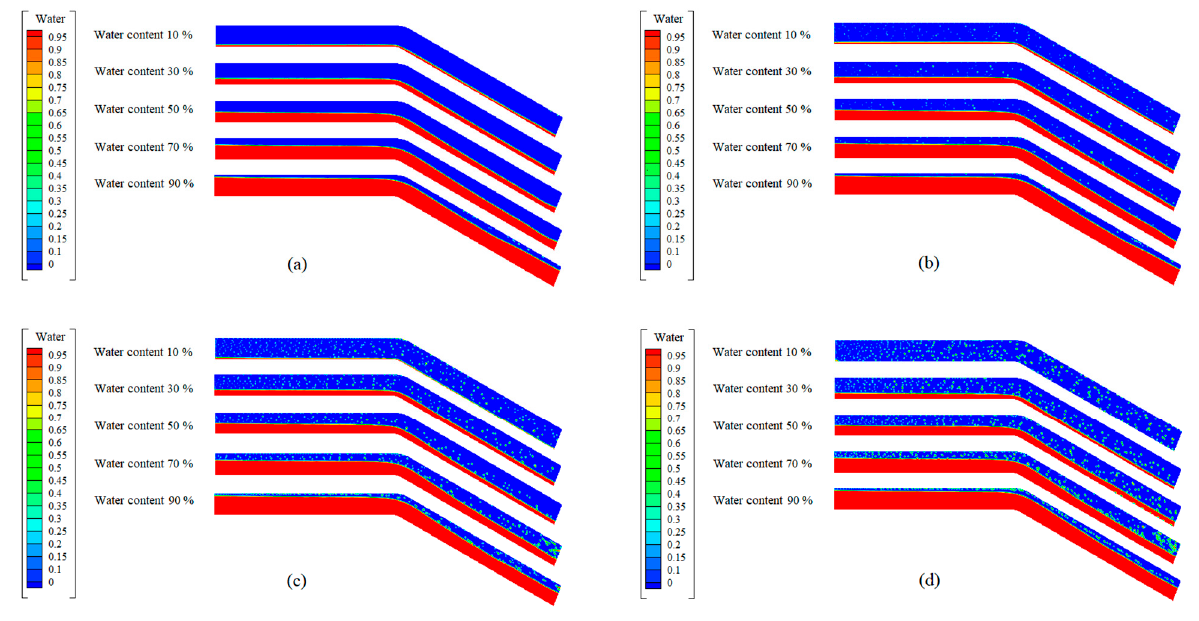
Figure 6. Distribution of the water phase in a downward-inclined pipe (30°) with different gas superficial velocities, where ( a ) 0.5 m/s, ( b ) 1 m/s, ( c ) 3 m/s, and ( d ) 5 m/s.